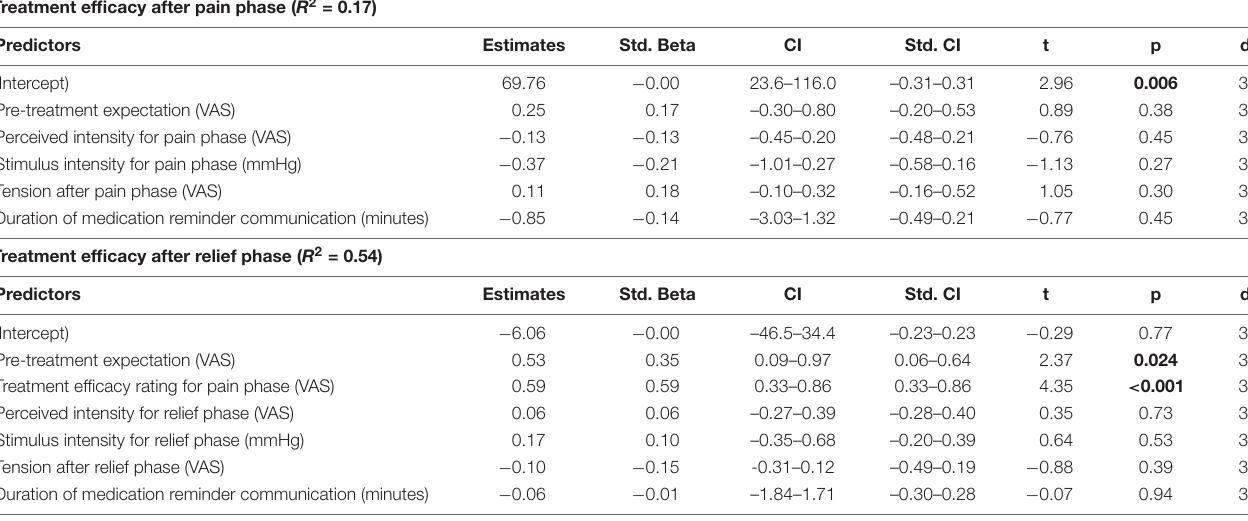
TABLE 2 | Predictors of treatment efficacy after pain and relief phases (Results of generalized linear models, GLM). Treatment efficacy after pain phase ( R 2 = 0.17)